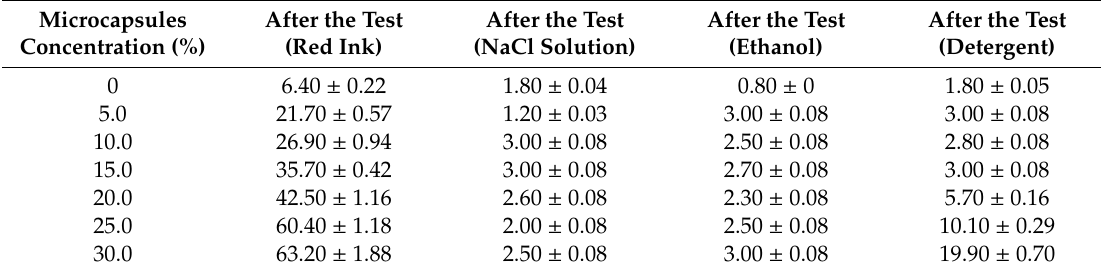
Table 6. E ff ect of microcapsule concentration on color di ff erence of primer film before and after liquid resistance.